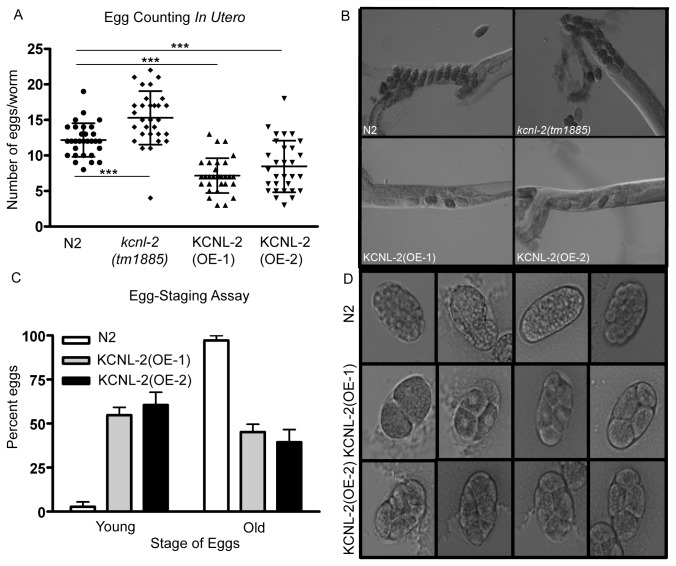
Overexpression of KCNL-2 in the N2 background causes a Hyperactive Egg-Laying Phenotype.A. An unlaid egg assay was carried out by dissolving the cuticle of adult worms in 1.8% sodium hypochlorite and shows that the number of eggs in utero in transgenic lines that overexpress KCNL-2 are significantly less than the number of eggs retained in utero in N2 and kcnl-2(tm1885) strains (p<0.001, Student’s t test), while kcnl-2(tm1885) has a significantly increased number of eggs retained in utero relative to N2 worms (p<0.001, Student’s t test). B) Representative images of worms from each strain. C) Egg-staging assays reveal that the proportion of young eggs from KCNL-2(OE-1) (strain VK1000) (54.82±7.65%) and KCNL-2(OE-2) (strain VK1065) (60.57±12.48%) was significantly greater than those of N2 worms (2.78±4.81%) (n=3, p<0.05; Kruskal–Wallis H test).